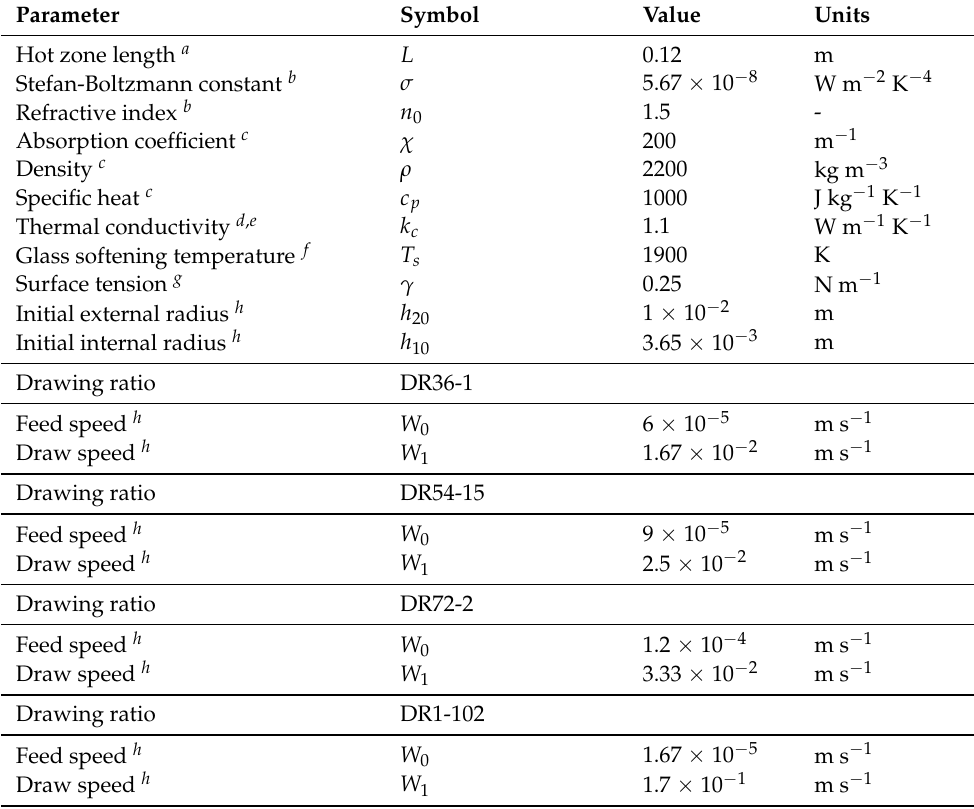
Table 1. Main parameters and initial values used for the simulations. a Voyce et al. [22], b Lee and Yaluria [36], c Paek and runk [16], d Taroni et al. [24], e Huang et al. [47], f Myers [17], g Fitt et al. [19], h Luzi et al.